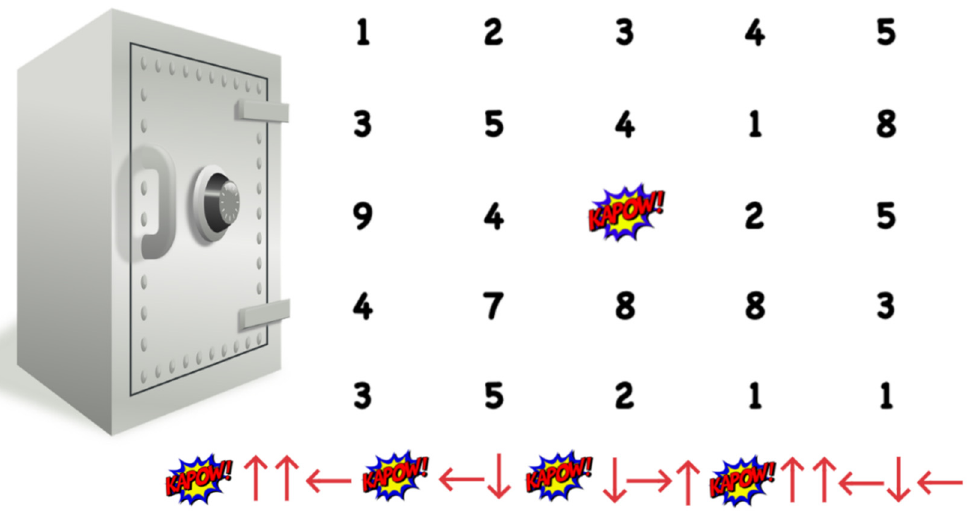
Figure 2. Playful challenge (Puzzle) in the escape room. The puzzle is solved by following the arrows from the “KAPOW!” icon, giving 2723 as a solution.